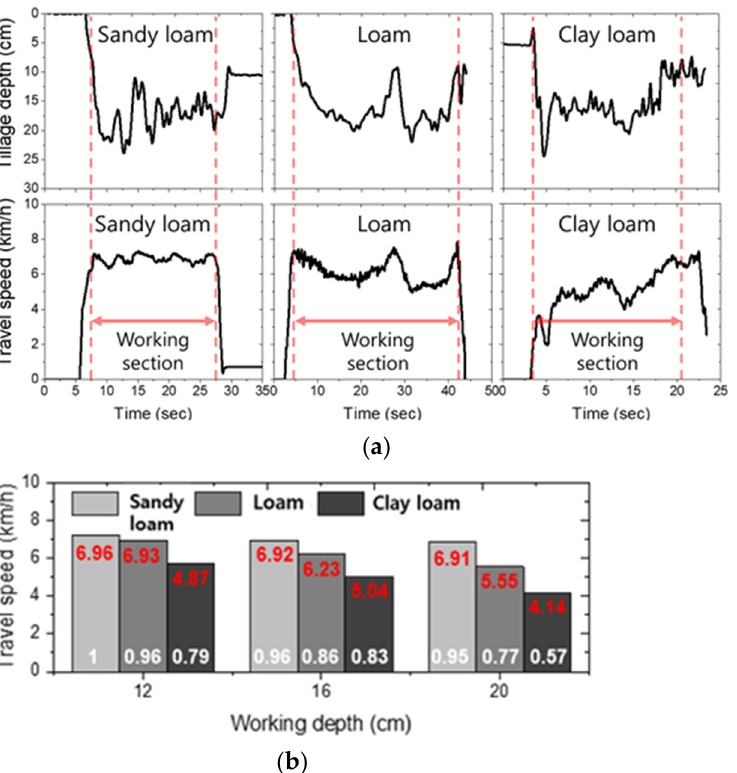
Figure 5. ( a ) Field measurements results of tillage depth and travel speed under various field sites; ( b ) Comparison analysis of travel speed by tillage depth and test sites.